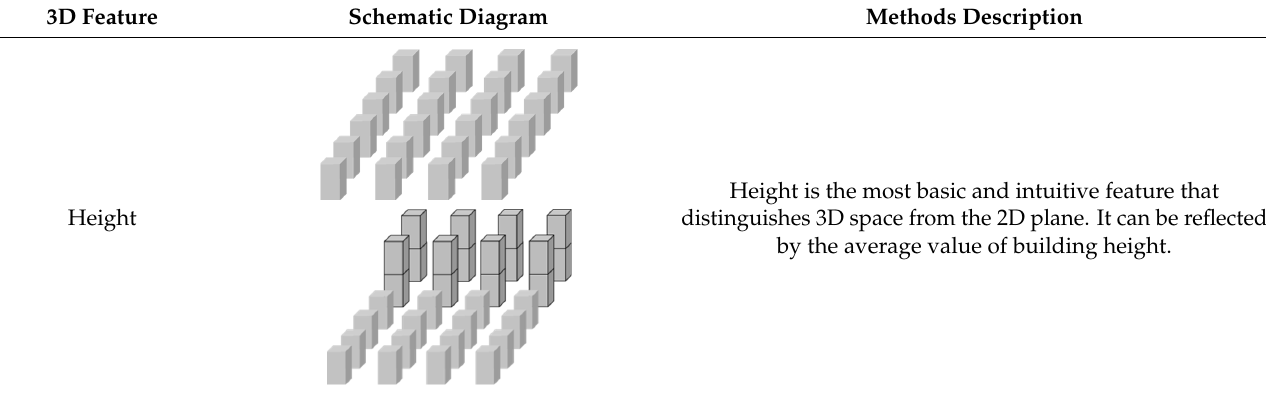
Table 1. Features and methods of 3D landscape pattern description.